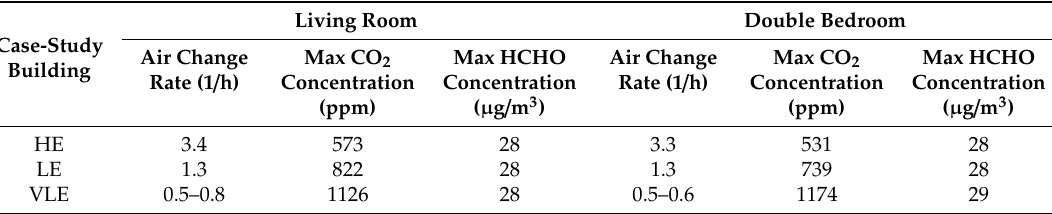
Table 3. Air change rate scheduled in each building model and the maximum CO 2 and formaldehyde concentration